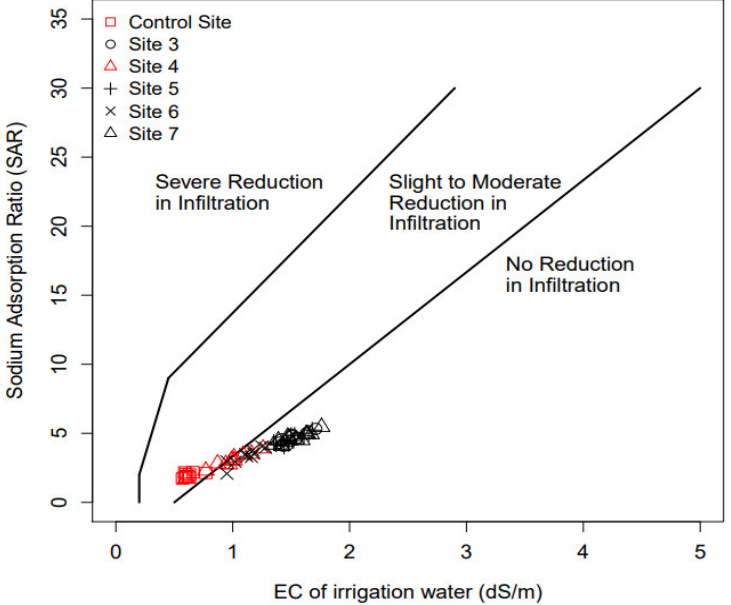
Figure A2. Effect of salinity and sodium adsorption ratio of irrigation water on infiltration rate. (Modified from Reference [6] (p. 44)).